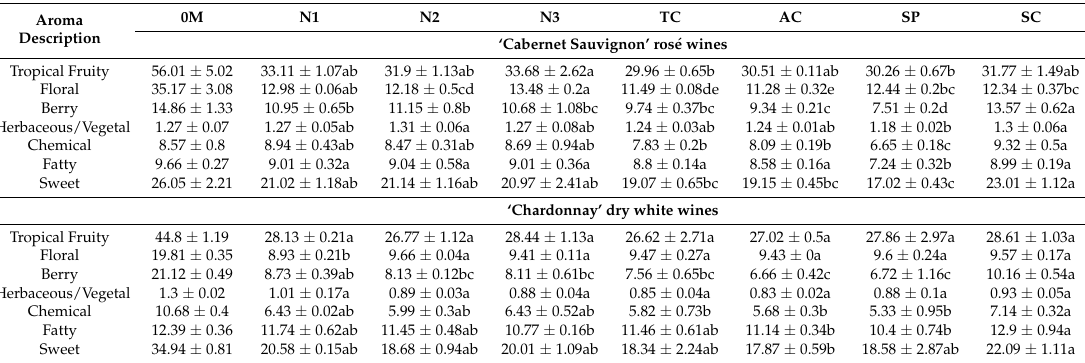
Table 2. OAVs in all initial wines (0M) and final wines (after an 18-month bottle aging). Aroma Description